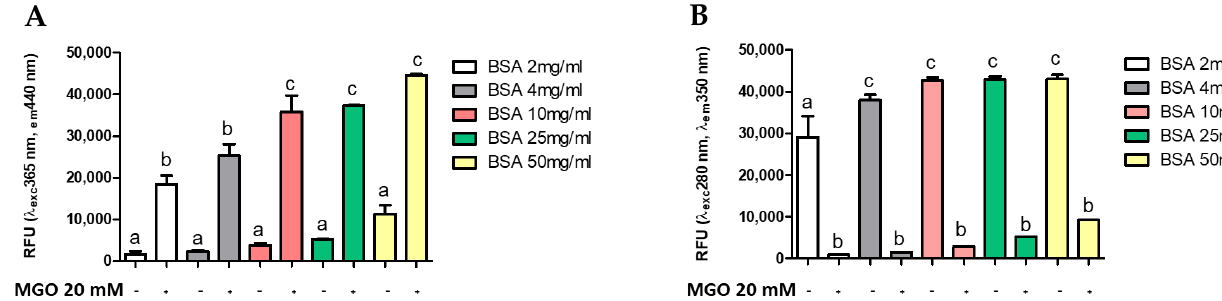
Figure 4. Fluorescence measurement of AGE after 168 h of incubation. All values are expressed as M ± SD ( n = 3). Data represent relative fluorescence units ( A ) RFU λ exc 365 nm/ λ em 440 nm and ( B ) RFU λ exc 280 nm/ λ em 350 nm of BSA non-glycated (BSA) and BSA glycated (BSA+MGO). Different letters represent significant differences among sample (ANOVA one-way and Tukey post-test).